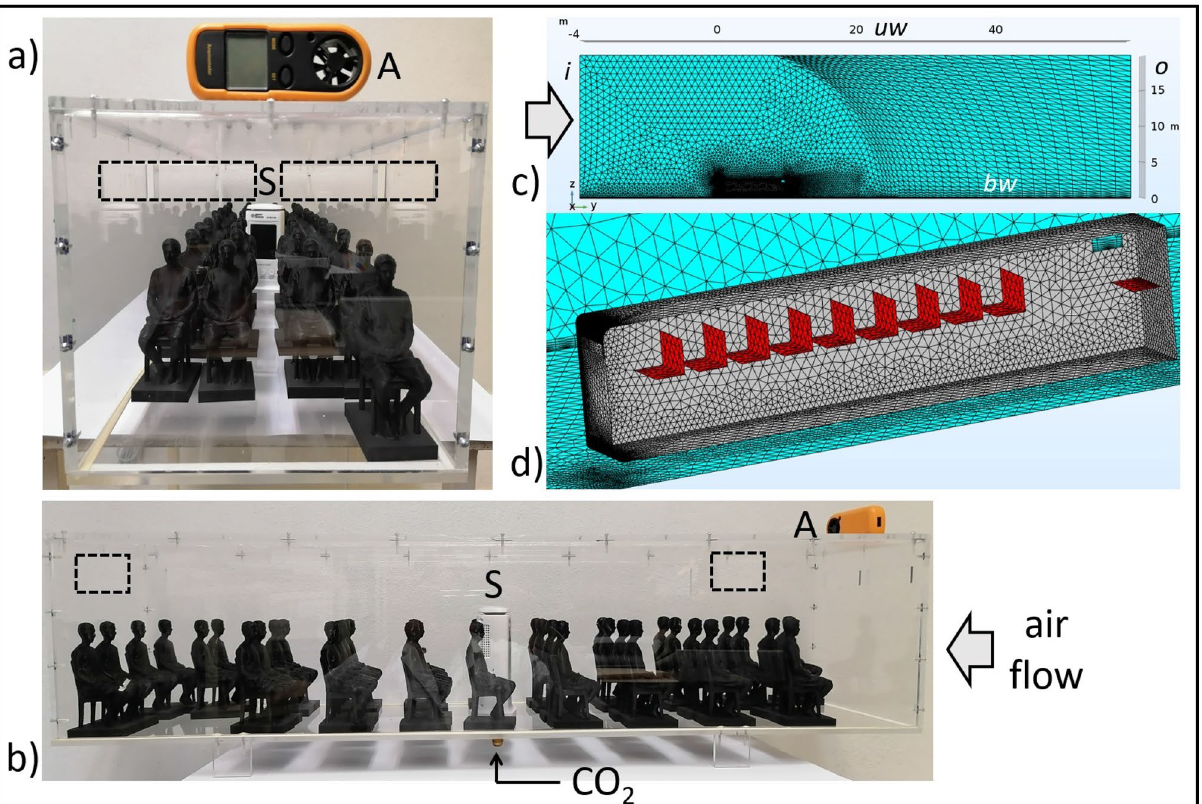
Figure 8. Numerical and experimental setups. ( a ) and ( b ) show the acrylic bus model (L = 1 m), including the 3D-printed passenger figures, the CO 2 feeding which is located at the middle of the bottom wall, the CO 2 sensor (S) and the anemometer (A). The position of the windows are marked with dashed lines to guide the eye. ( c ) shows a panoramic view of the whole numerical domain, including the inlet wall (i) where air enters the domain, the outlet wall (o) and the upper wall (uw) which are considered open boundaries, as well as the bottom wall (bw) on which the no-slip condition is applied. The denser mesh region is where the bus is located; ( d ) zoom of the numerical domain showing the bus bodywork (gray) and the external walls (blue); the seats are marked in